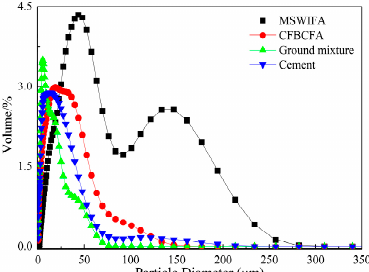
Figure 2. The particle size distributions of the raw materials and ground